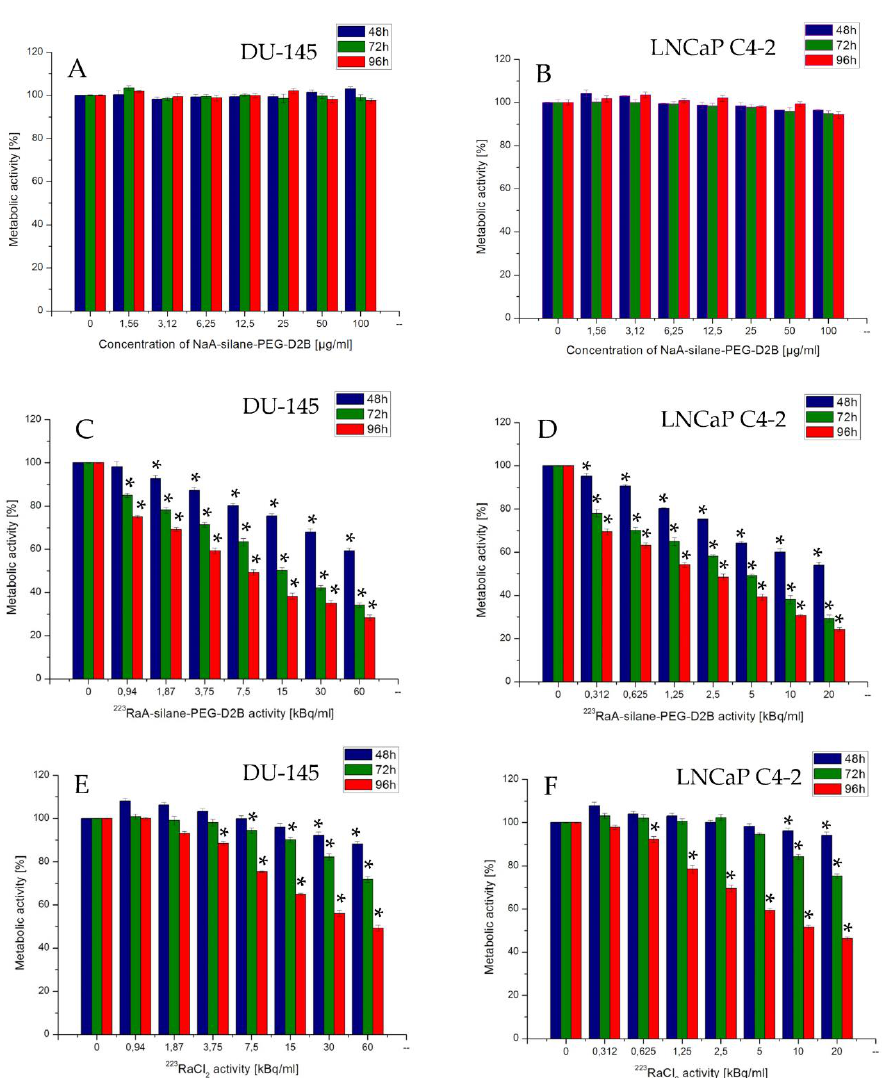
Figure 8. Metabolic activity of DU-145 and LNCaP C4-2 cells cells treated with di ff erent concentrations of immunoconjugate NaA-silane-PEG-D2B ( A , B ), radioimmunoconjugate 223 RaA-silane-PEG-D2B ( C , D ) and 223 RaCl 2 ( E , F ) for 48 h, 72 h, or 96 h. Data are expressed as a percent of control, mean ± SD from three independent experiments ( * denotes statistically significant di ff erence from unexposed control, p < 0.05).